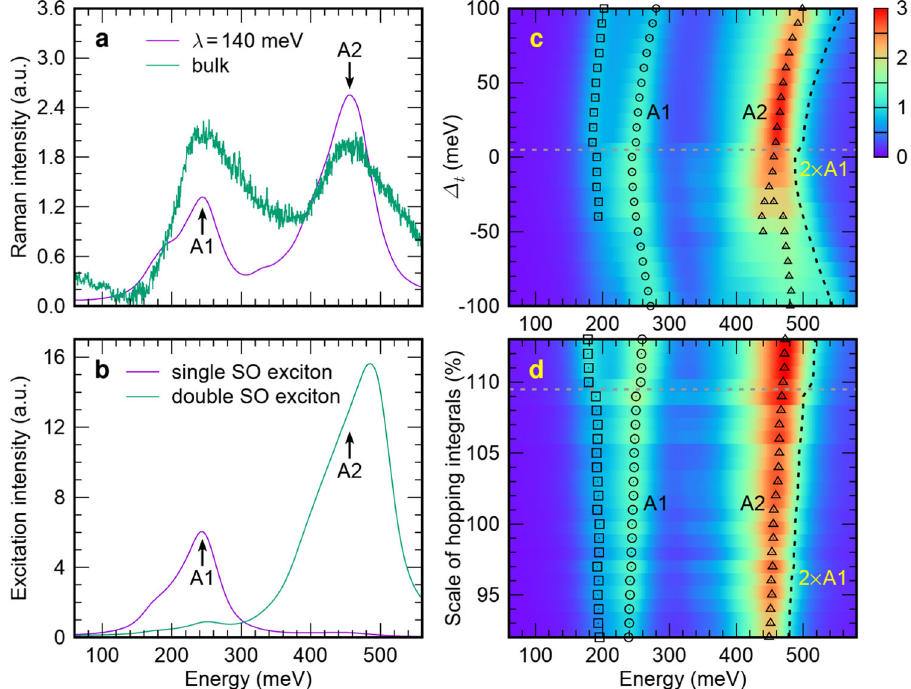
Fig. 4 Calculated spin-orbit excitons. a Theoretical Raman spectra in RL polarization calculated with the physical parameters listed in Table 2. The light green line refers to the measured Raman spectra of the bulk sample. b Distributions of single and double spin-orbit (SO) exciton states. Arrows in a , b indicate the theoretical positions of A1 and A2 peaks. c , d Evolution of Raman intensities and the A1 and A2 peaks as (cid:2) E functions of trigonal distortion parameter Δ t ( ¼ E a e π g ) and scaled hopping integral strengths. The parameter set is detailed in Table 2. The 1 g dotted lines in c , d are twice the A1 peak. Horizontal gray dotted lines in c , d indicate the speci fi c values of the trigonal distortion and scaled hopping integral strengths, which show a discontinuous variation of the peak positions.